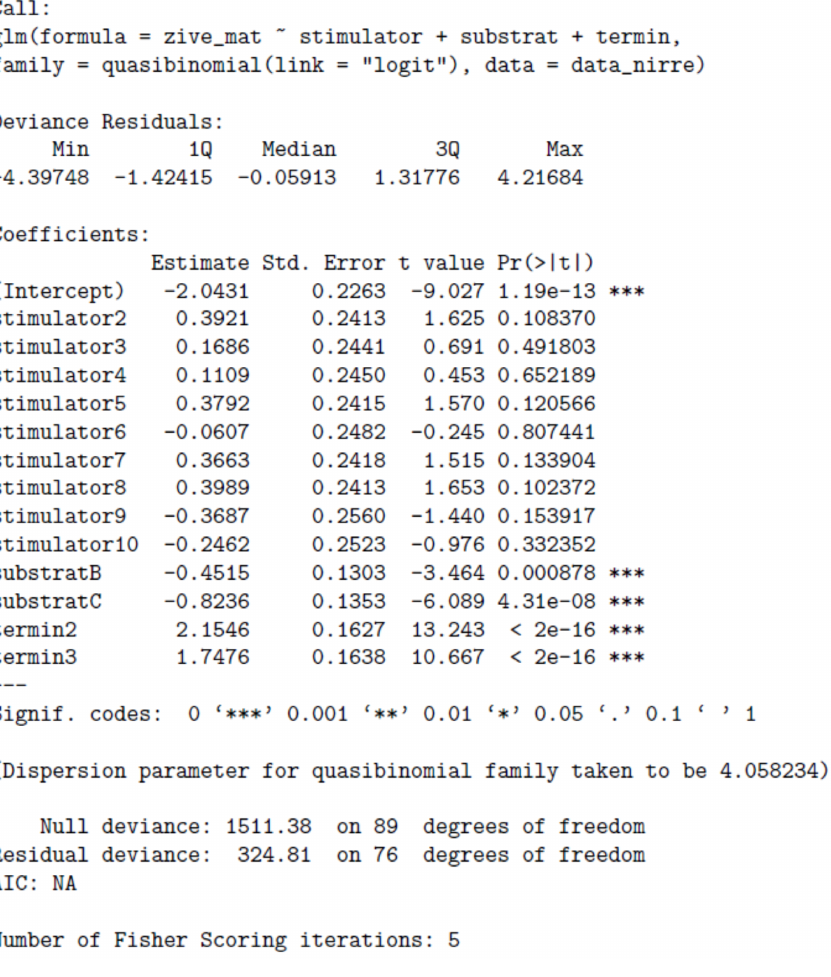
Figure A3. Parametrization of the quasi-binomial model predicting the proportion of surviving cuttings from all cuttings, including Wald tests of the significance of differences between the reference (Stimulator 1, Substrate A, Date 1) and remaining levels of each factor.